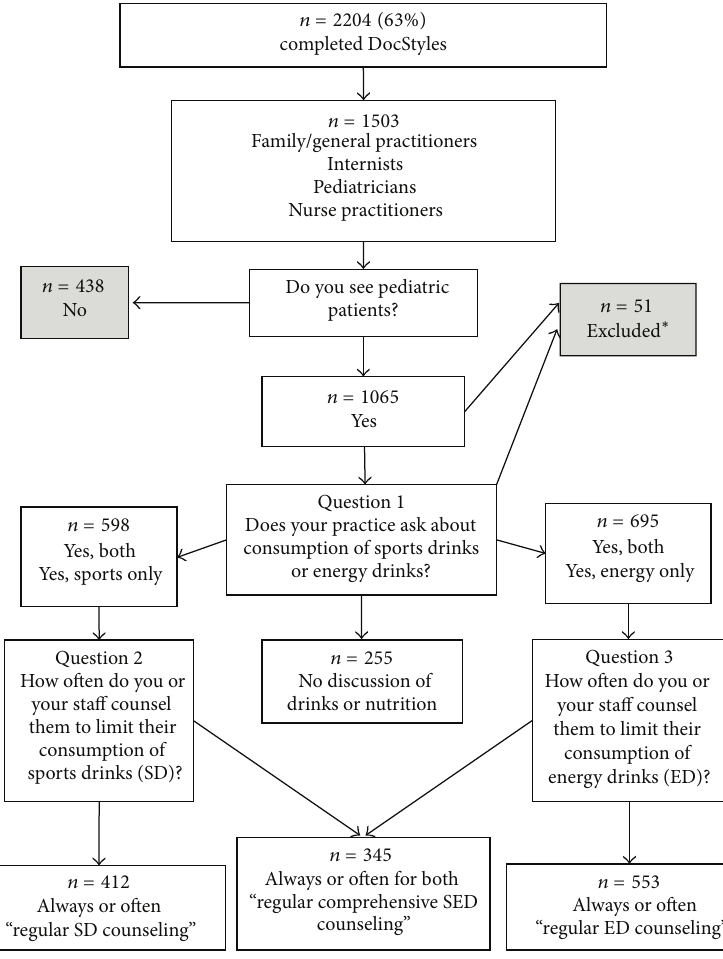
Figure 1: Flowchart of DocStyles 2011 survey questions regarding sports and energy drink counseling practices among healthcare providers. This flowchart depicts the questions used in this analysis of the DocStyles 2011 survey and how providers were categorized regarding their counseling patterns around sports (SD) and energy (ED) drinks. This categorization formed the basis of the analyses. Individuals answering “both” or “SD only” to Question 1 were asked Question 2. Those who responded with “both” or “ED only” were asked Question 3. Regular SD counseling was defined as those individuals who regularly (“Always” or “Often”) counseled on reducing SD consumption. Regular ED counseling was defined similarly. Comprehensive SED counseling was defined as individuals who counseled on “Both drink types” and counseled regularly for both. ∗ indicates patients excluded from sample due to missing/incomplete demographic information ( 𝑛 = 10 ), responses to Questions 2 or 3 that are contradictory to responses to Question 1 ( 𝑛 = 9 ), or answering “Not Sure” to Question 1 ( 𝑛 = 32